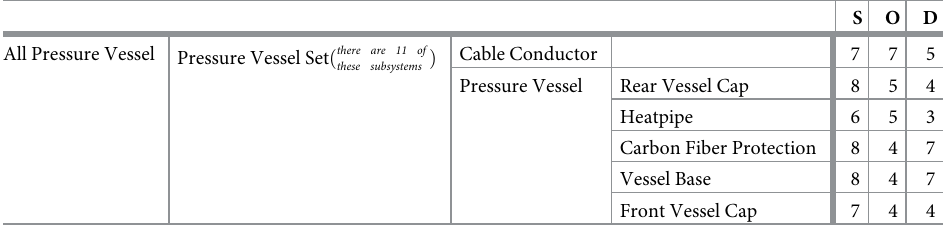
S = Severity, O = Occurrence, D =